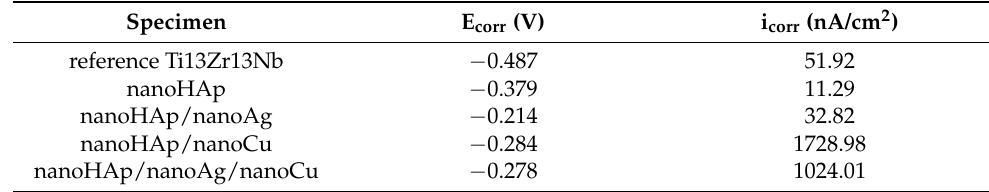
Figure 2. Potentiodynamic curves of the tested: ( a ) reference Ti13Zr13Nb alloy, nanoHAp and nanoHAp/nanoAg coatings, ( b ) nanoHAp/nanoCu coating and ( c ) nanoHAp/nanoAg/nanoCu coating. Table 3. Corrosion parameters of the tested reference Ti13Zr13Nb alloy and nanoHAp-based coatings.